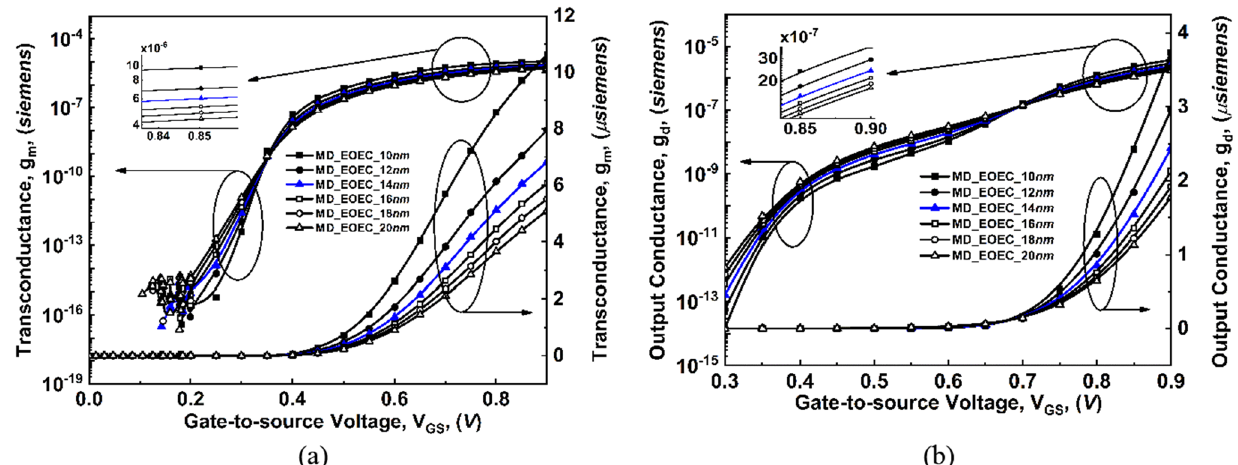
Figure 10. Comparison of variation of transconductance (g m ) and output conductance (g d ) as a function of gate voltage at V DS = 0.3 V for EOEC devices: ( a ) g m , and ( b ) g d